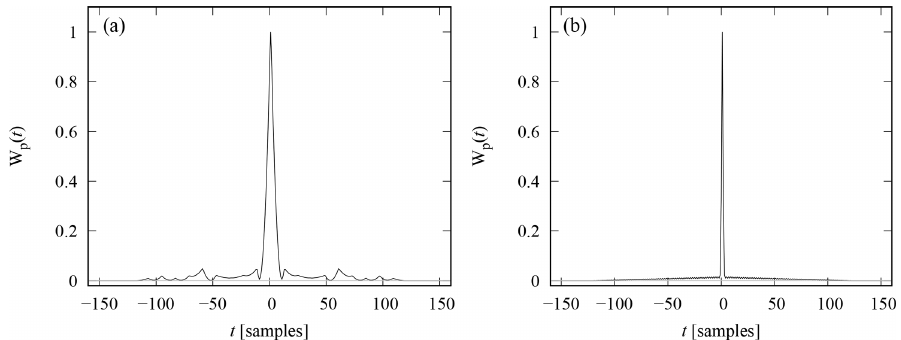
Figure 5. Zero-lag range ambiguity functions in the PMWE observation (a) and in the PMSE observation (b) . The pair of 10-bit codes used in the PMWE observation produces significant side lobes in matched filter decoding, while the sequence of 128 61-bit codes used in the PMSE observation leads to a smooth pattern of smaller side